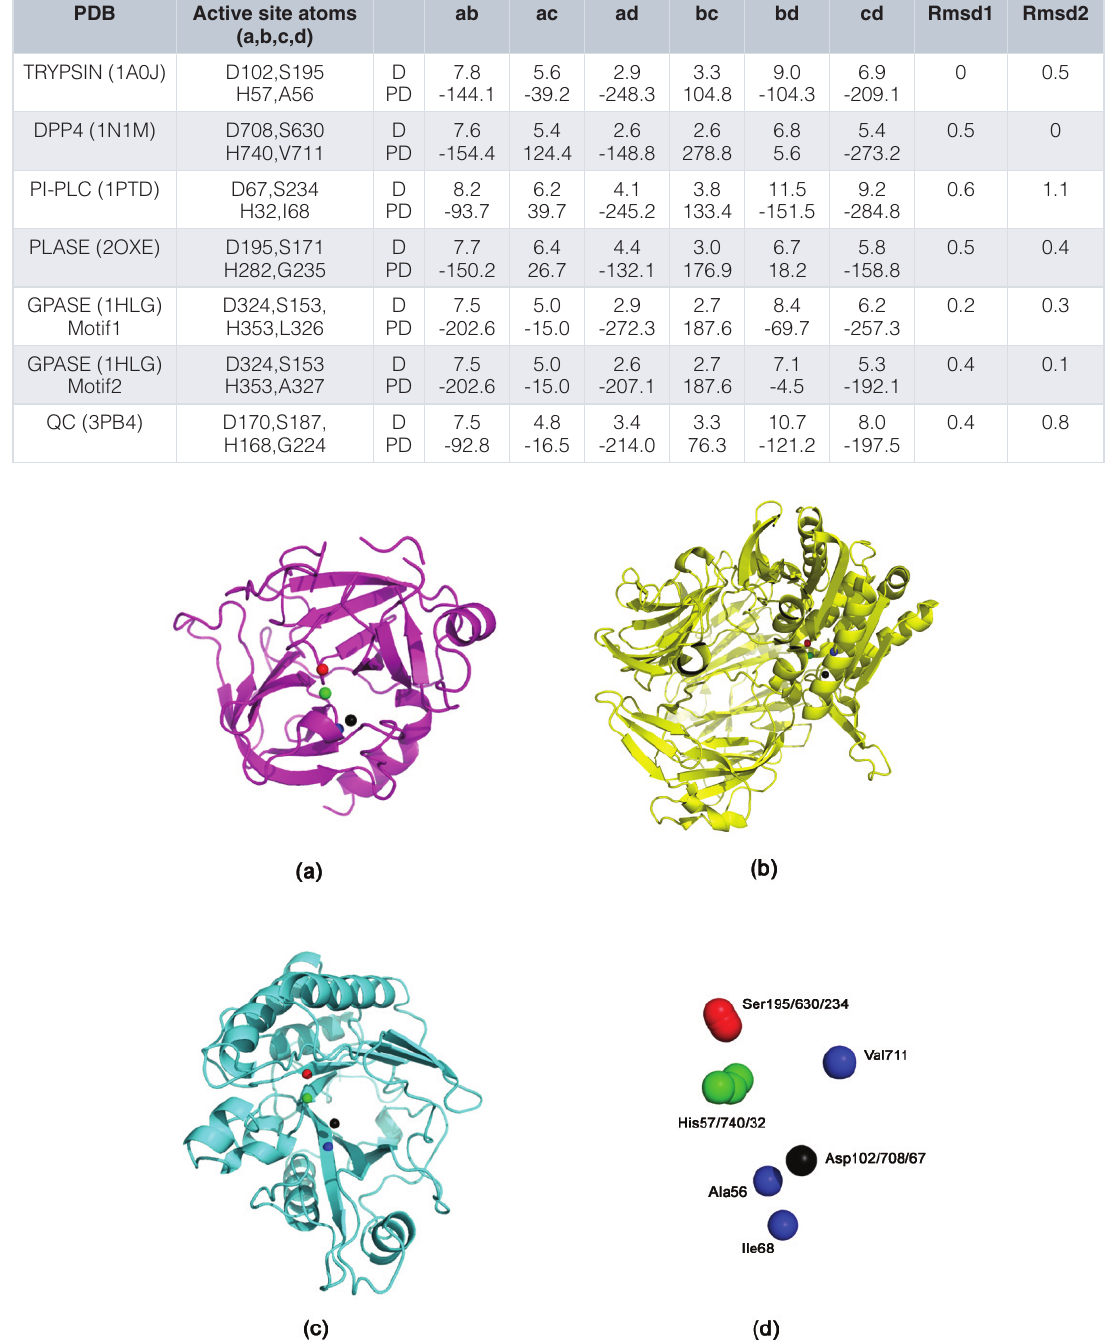
Figure 1. The active site residues in Trypsin, DPP4 and PI-PLC. ( a ) Trypsin (PDBid:1A0J) ( b ) DPP4 (PDBid:1N1M); ( c ) PI-PLC (PDBid:1PTD) ( d ) Superimposing the active site residues using DE- CAAF 35 . The superimposition can be viewed in Superimposeproteins.p1m in Dataset